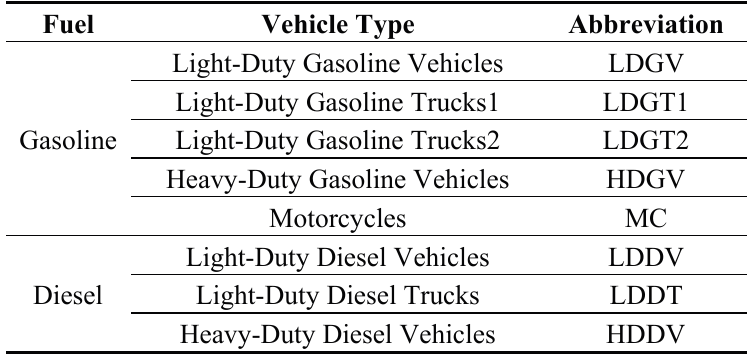
Table 3. Vehicle types by fuel and abbreviations.